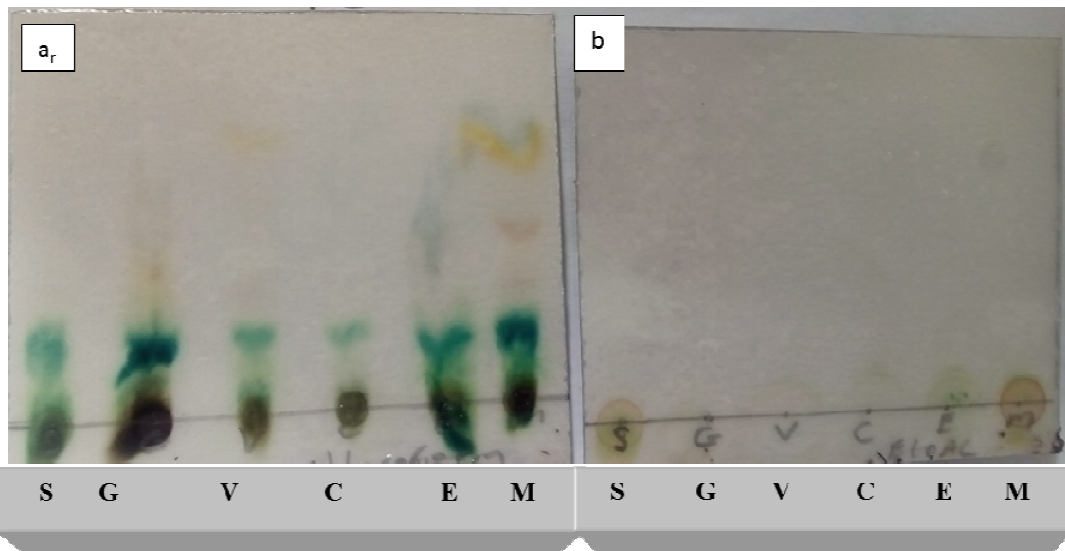
Fig. 1. TLC profile of steroids in chloroform (a) and ethanolic (b) extracts of F. sycomorus (S), F. glumosa (G), F. vogelli (V), F. cordata (C), F. exasperata (E) and F. mucuso (M)